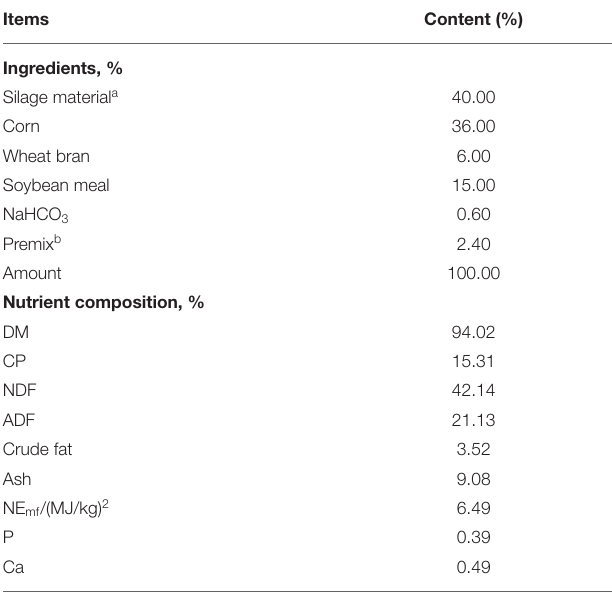
TABLE 1 | Ingredients and nutrient composition of diets for the